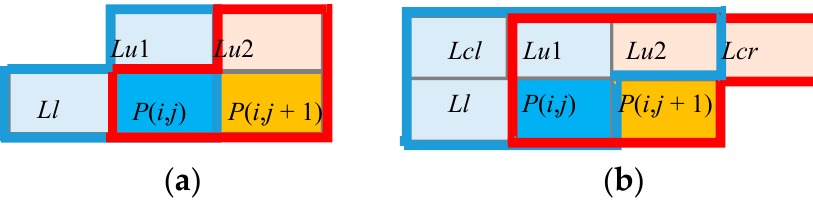
Figure 6. The neighborhoods of two adjacent input pixels: ( a ) four-connected; ( b ) eight-connected. Table 1. Rules to apply to four-connected neighborhoods for labeling two adjacent pixels in parallel.